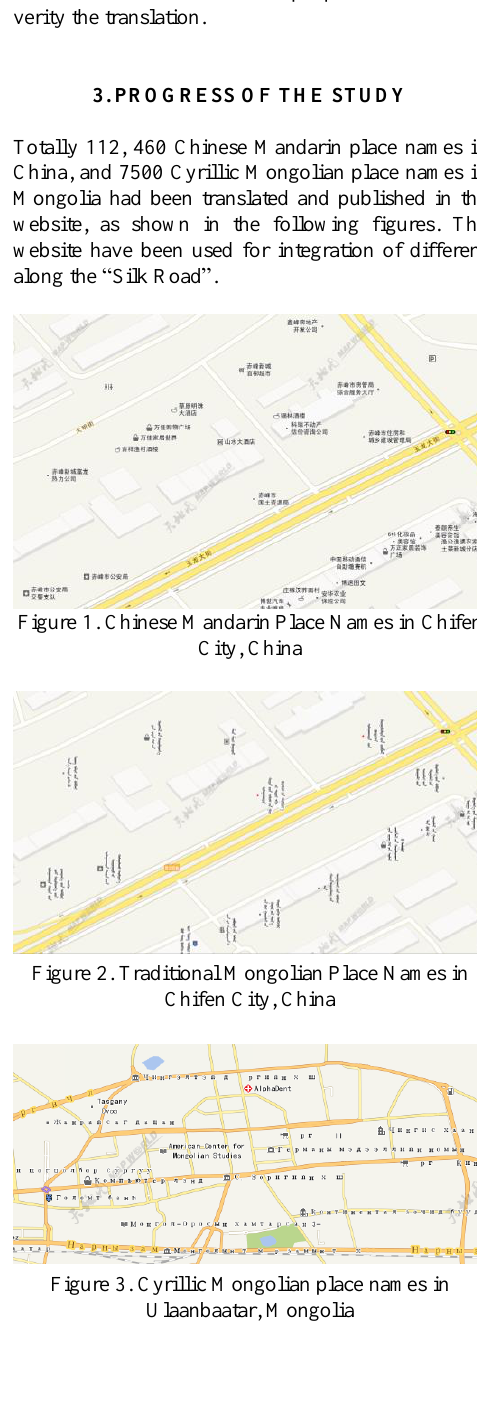
Figure 4. Traditional Mongolian place names in